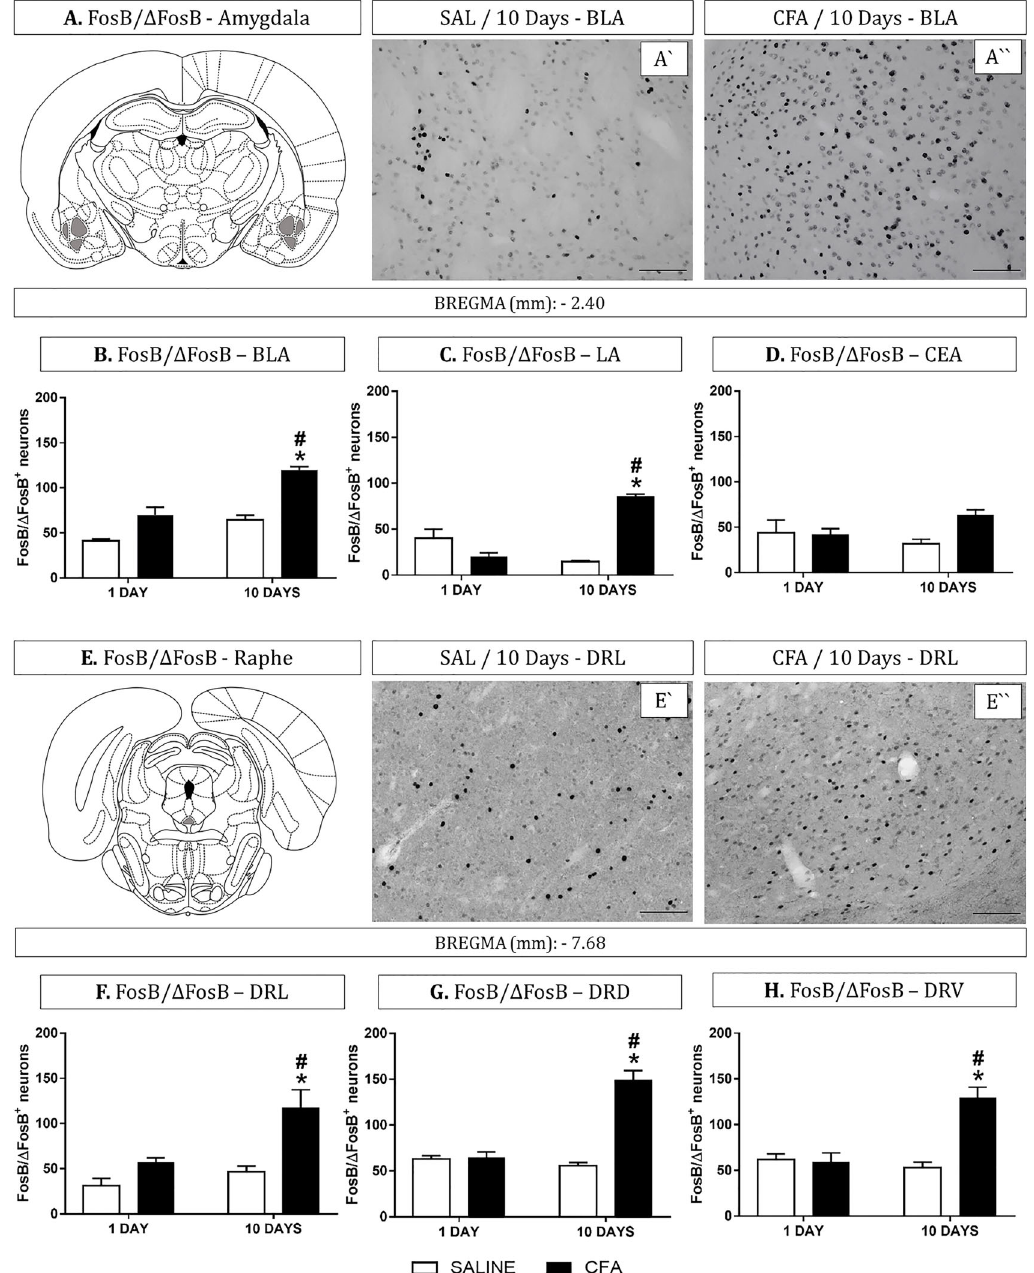
Figure 1. Subregions of the amygdala and dorsal raphe nucleus were analyzed for neuronal activation in complete Freund ’ s adjuvant (CFA)-induced temporomandibular in fl ammation (1 or 10 days) and rats administered saline (SAL) (n=6 – 7 per group). A , Plate adapted from Paxinos and Watson Atlas (26; Elsevier Academic Press) of basolateral nucleus of the amygdala (BLA); A ’ , photomicrograph of FosB/ D FosB staining in the BLA of a representative rat from the Day 10/saline-treated group and A ’’ , from the Day 10/CFA-treated group. Graphs show FosB/ D FosB immunohistochemistry (IR) quanti fi cation in BLA - B , lateral (LA - C ), and central nuclei of the amygdala (CEA - D ) ( – 2.40 mm bregma). E , Plate adapted from Paxinos and Watson Atlas (26; Elsevier Academic Press) of the ventral division of the dorsal raphe (DRV); E ’ , photomicrograph of FosB/ D FosB IR in the DRL of a representative rat from the Day 10/saline treated group and E ’’ , from the Day 10/CFA treated group. Graphs show FosB/ D FosB IR quanti fi cation in lateral (DRL - F ), dorsomedial (DRD - G ), and ventral divisions (DRV - H ) of the dorsal raphe nucleus ( – 7.68 bregma). Data are reported as means ± SE. *P o 0.05 vs Day10/control group (saline), # P o 0.05 vs Day 1/CFA group (Newman-Keuls test). Magni fi cation, 20 (cid:3) ; scale bars, 100 m